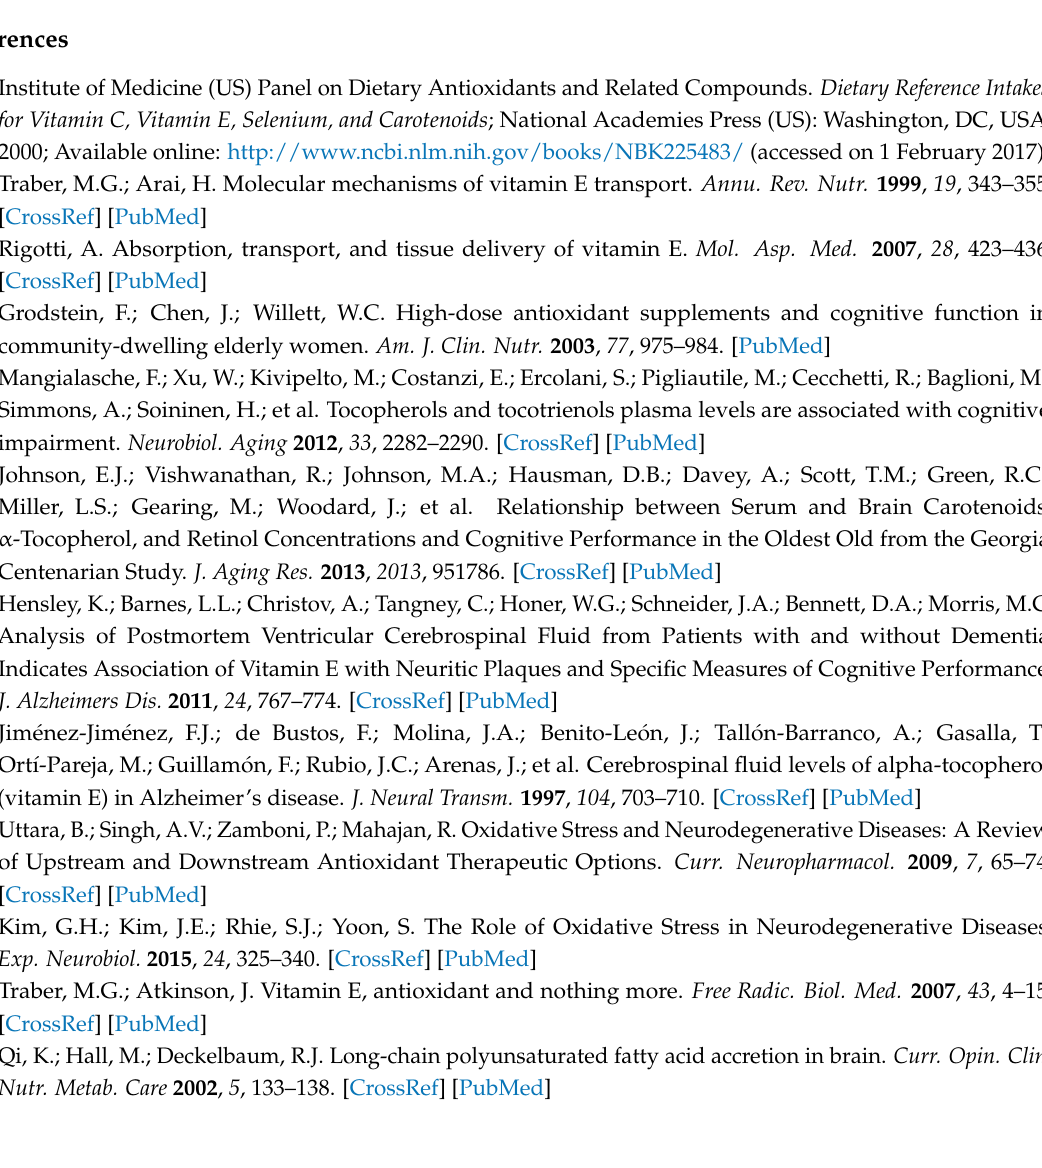
Figure S1. Mean γ -tocopherol concentrations (ng/mg protein, ± SD) in different regions of the brain from adult rhesus macaques ( n = 9), Figure S2. Mean ( ± SD) ratio of α -tocopherol/ γ -tocopherol in different regions of the brain from adult rhesus macaques ( n = 9). Figure S3. Membrane γ -tocopherol concentrations (ng/mg protein, mean ± SD) in (A) prefrontal cortex (B) cerebellum (C) striatum (D) hippocampus of adult rhesus macaques ( n = 9), Table S1. Mean ( ± SD) mole percent fatty acids in prefrontal cortex membranes of adult rhesus macaques ( n = 9), Table S2. Mean ( ± SD) mole percent fatty acids in cerebellar membranes of adult rhesus macaques ( n = 9), Table S3. Mean ( ± SD) mole percent fatty acids in striatal membranes of adult rhesus macaques ( n = 9), Table S4. Mean ( ± SD) mole percent fatty acids in hippocampal membranes of adult rhesus macaques ( n =